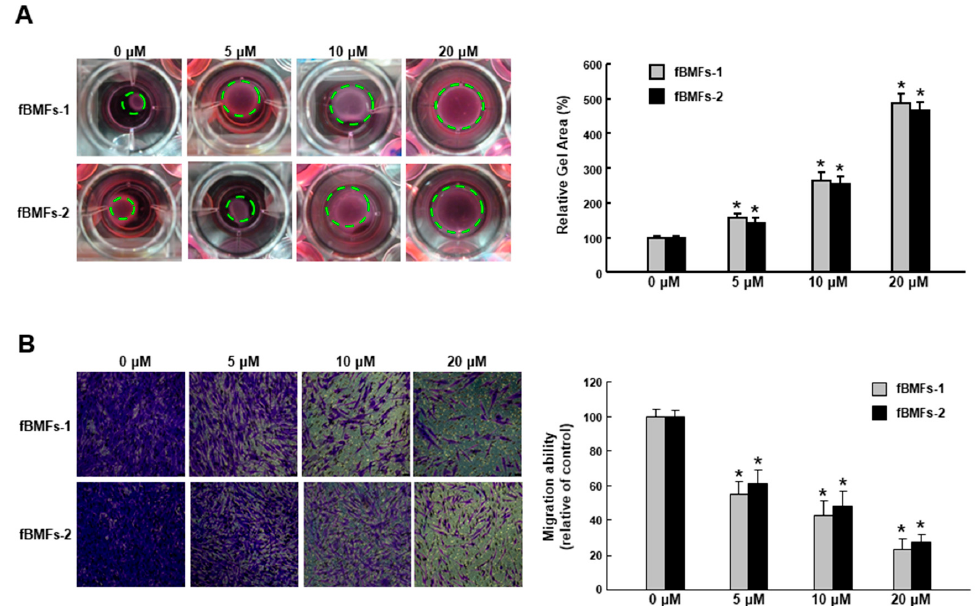
Figure 4. Arctigenin suppresses the collagen gel contraction and invasion capabilities of fBMFs. Myofibroblast activities were determined by ( A ) collagen gel contraction and ( B ) migration in fBMFs treated with various concentrations of arctigenin. The experiments were repeated three times, and representative results are shown. The results are means ± SD. * p < 0.05 as compared with the non-arctigenin-treated group. Magnification, × 200. Int. J. Mol. Sci. 2019 , 20 , x FOR PEER REVIEW